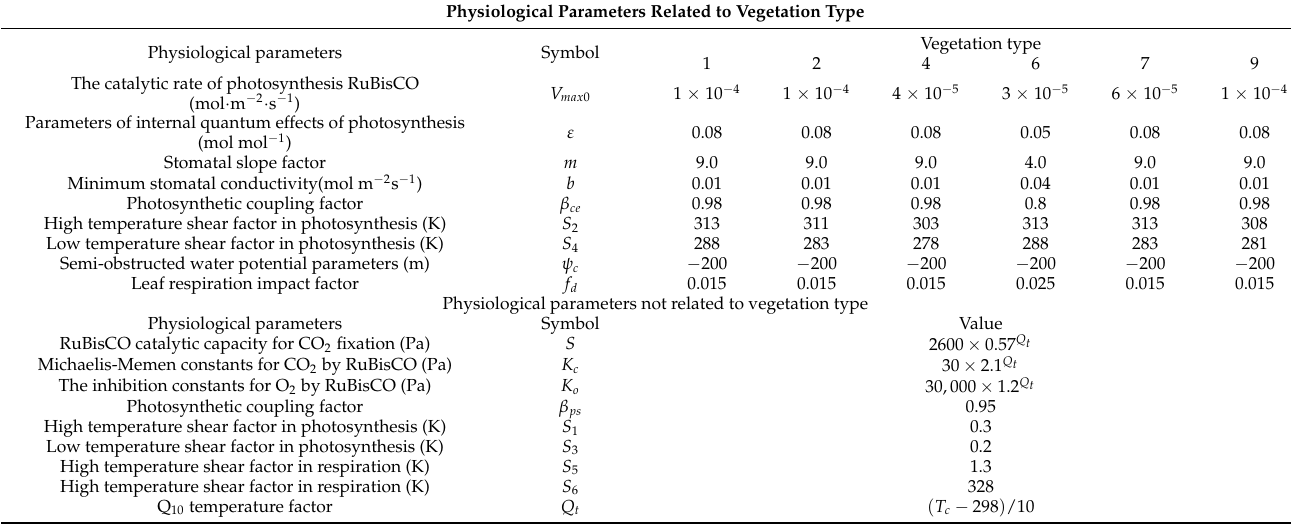
Table A5. Vegetation physiological